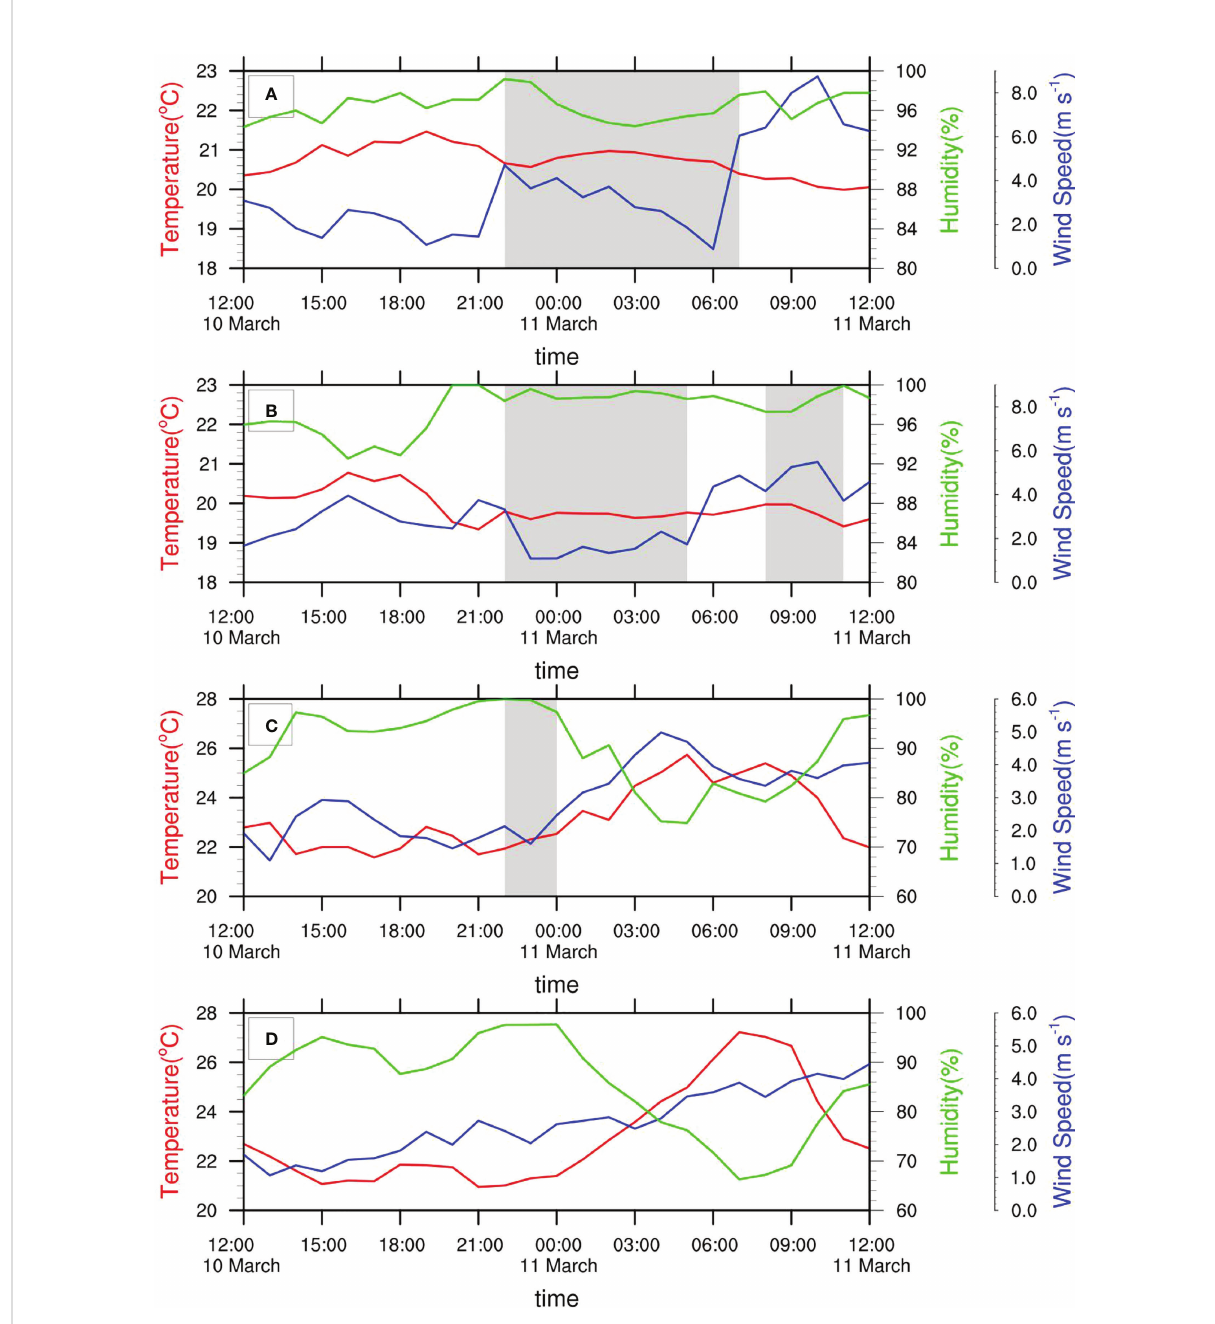
FIGURE 6 Time series of wind speed, air temperature, humidity, and fog duration (gray shaded areas) at station A [ (A) for the coupled model; (B) for the uncoupled model] and station B (C) for the coupled model; (D) for the uncoupled